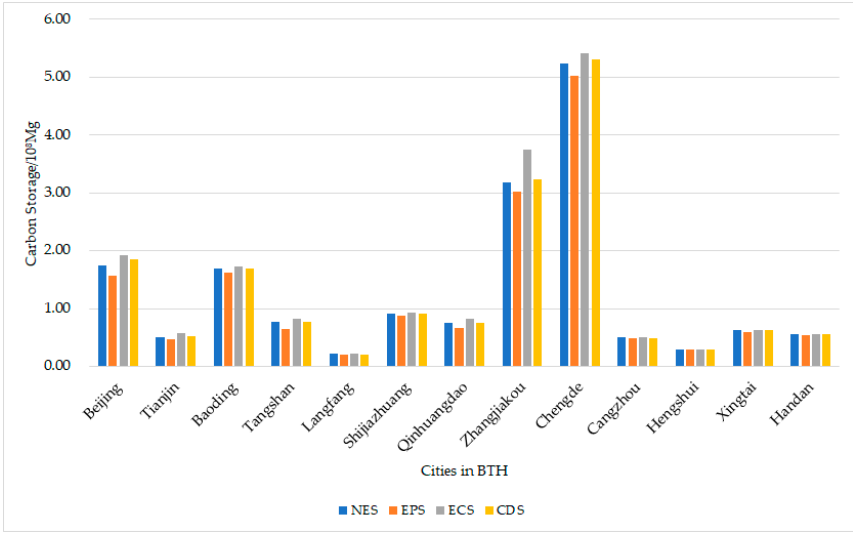
Figure 12. The predicted carbon storage of cities in 2035 under four scenarios.